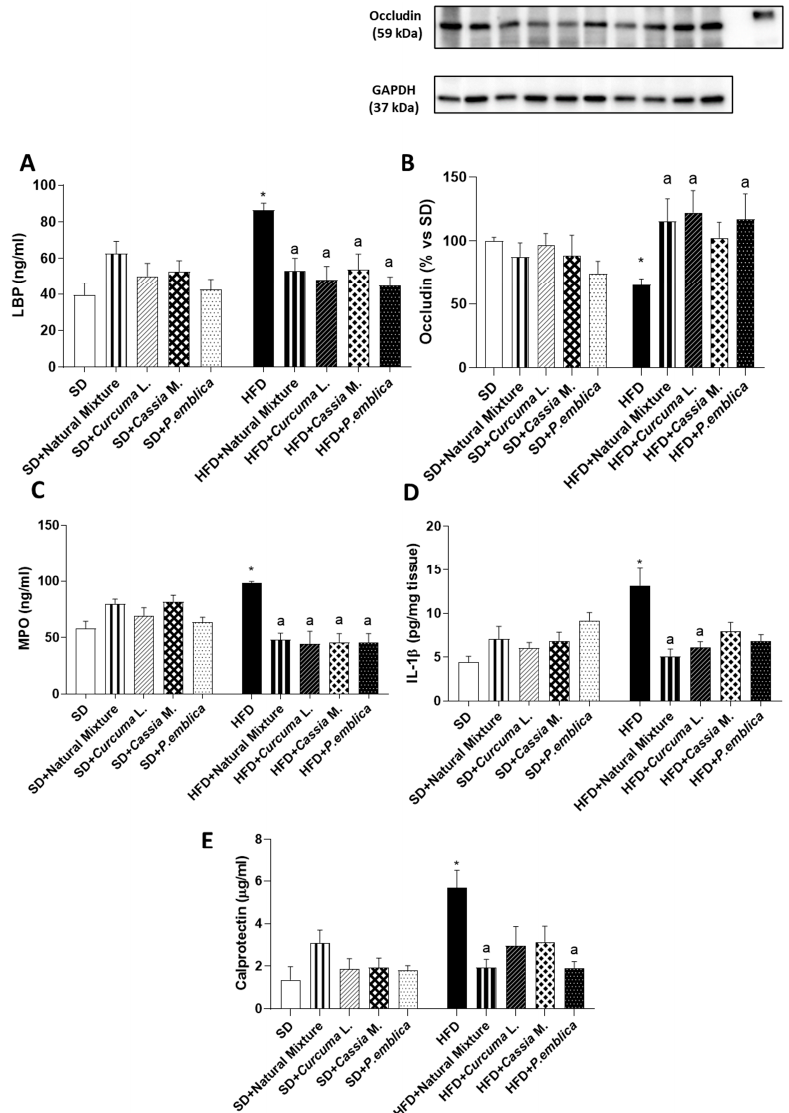
Figure 3. ( A ) Circulating LBP in SD and HFD mice treated with natural mixture, Curcuma L., Cassia M. and P. emblica . ( B ) Densitometric analysis and representative blots of occludin expression in colonic tissues from HFD- and SD-fed mice treated with natural mixtures and each single component. Levels of ( C ) plasmatic MPO and ( D ) colonic IL- β from SD and HFD mice treated with natural mixture and each single component. ( E ) Calprotectin levels in fecal samples from SD and HFD mice treated with natural mixture, Curcuma L., Cassia M. and P. emblica . Each column shows the mean ± SEM ( n = 6). One-way ANOVA and Tukey post hoc test results are as follows: *— p < 0.05 for significant difference vs. the SD group, and a — p < 0.05 for significant difference vs. the HFD group. Abbreviations: